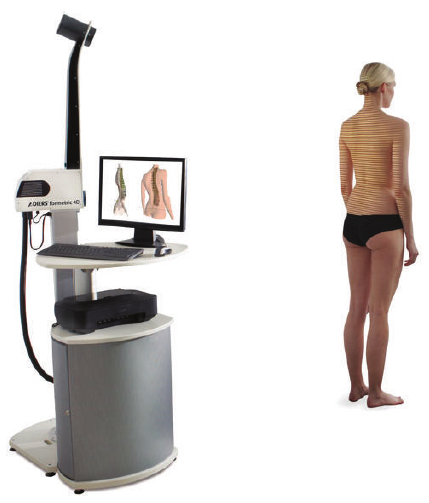
Figure 3: Formetric 4D device with raster line projection.